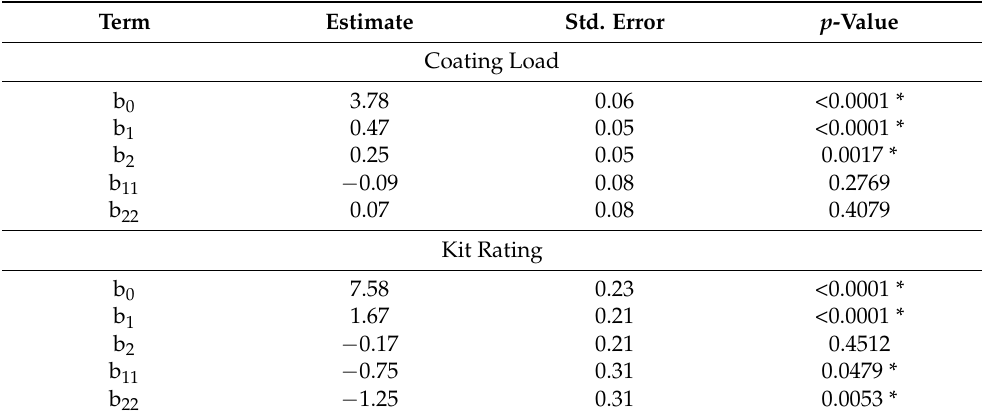
Table 2. Regression coefficients of the second-order polynomial model. Term